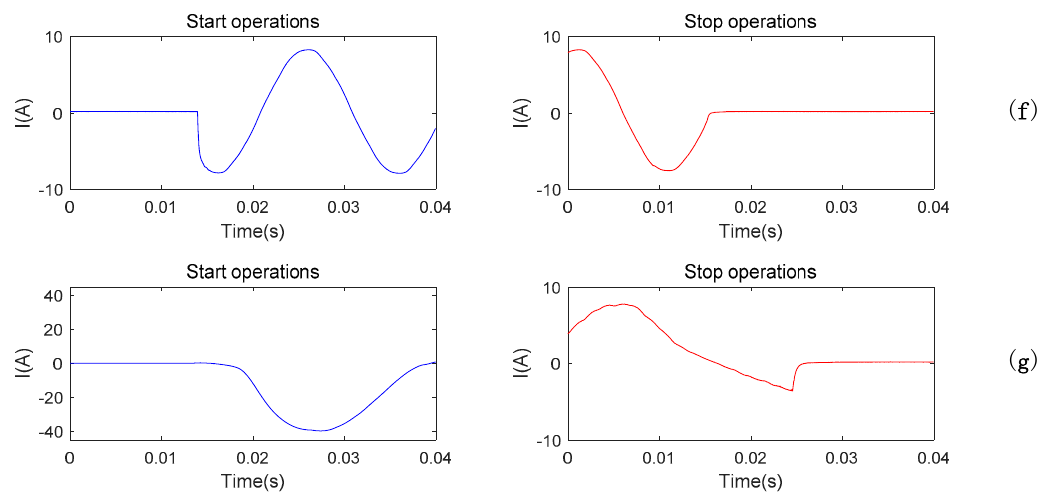
Figure 17. The waveform of di ff erent load types during the start operations and stop operations. ( a ) induction cooker. ( b ) incandescent lamp. ( c ) hairdryer. ( d ) notebook computer. ( e ) electric drill. ( f ) electric oven. ( g ) vacuum cleaner. Table 6. Detection results of RF.